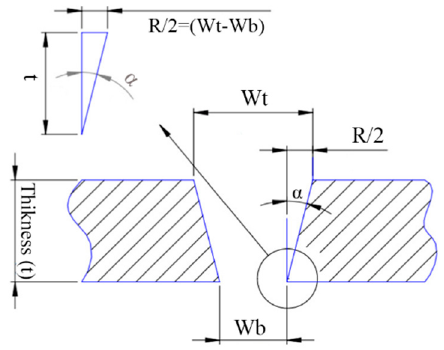
Figure 3. Cross-section of the top and bottom kerf.